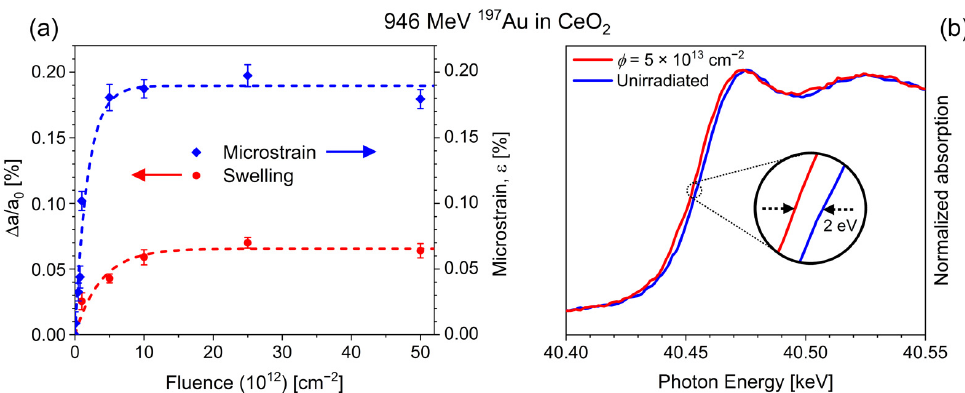
Figure 3. Structural and chemical changes in CeO 2 after irradiation with 946 MeV 197 Au ions, as adapted from Tracy et al. [47]. ( a ) Relative change in unit cell parameter (red) and heterogeneous microstrain (blue) based on X-ray diffraction meas- urements as a function of ion fluence and ( b ) corresponding X-ray absorption spectroscopy measurements of an unirradi- ated (blue) sample and after irradiation to a fluence of 5 × 10 13 ions/cm 2 (red). XAS and XPS measurements on SHI irradiated CeO 2 reveal that structural changes are accompanied by partial reduction of nominally Ce 4+ cations to Ce 3+ [34,39,47,52,55,59]. XAS spectra show a shift in the K-edge absorption energy of approximately − 2 eV (Figure 3b), which suggests a partial reduction to the trivalent state rather than the transition of all cerium cations to the trivalent state, which corresponds to a shift of − 7 eV [65]. This evidence of SHI irradiation-induced reduction is corroborated by magnetic measurements that display ferromagnetism in SHI irradiated CeO 2 , indicative of the magnetic moments produced by the 4f electrons in Ce 3+ cations [39,57]. Iwase et al. [34] observed a saturation of this redox behavior at a Ce 3+ /Ce 4+ ratio of ~12% at a maximum fluence of 6 × 10 13 ions/cm 2 using 200 MeV 132 Xe ions. Coupled XRD and XAS measurements by Tracy et al. [47,60] revealed that the observed redox changes are directly linked with unit cell swelling and microstrain buildup, as the fluorite structure must distort to accommodate larger trivalent cations (1.14 Å versus 0.97 Å of initial tetravalent cations), as well as oxygen vacancies [4]. In certain cases, irradiation induced reduction occurs to a sufficient extent that the for- mation of a secondary phase is observed at high fluences [43,47,53]. This hypostoichio- metric trigonal Ce 11 O 20 phase consists of Ce 4+ and Ce 3+ cations along with ordered oxygen vacancies. While changes in unit cell parameter and microstrain of CeO 2 (Figure 3a) follow a behavior that is consistent with a single impact model [31,47] (Equation (3)), it remains unclear whether or not the induced redox changes follow the same trend. XPS data from Iwase et al. [34] suggest a single impact mechanism for redox effects, based on the increase